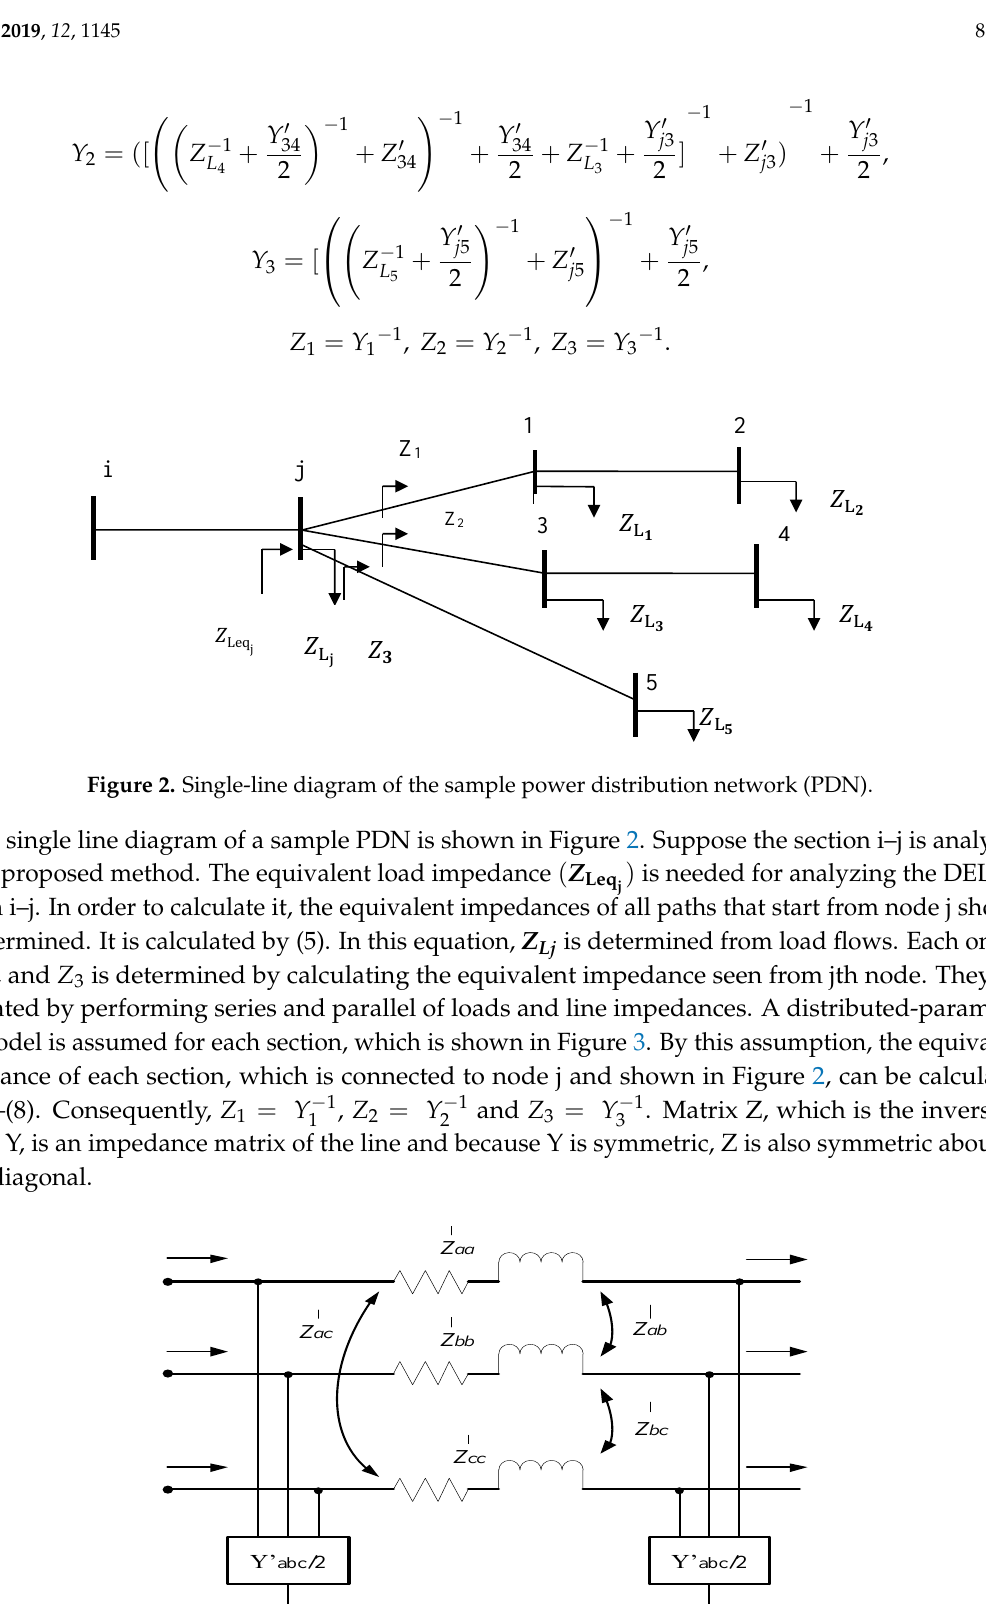
Figure 3. Circuit model of each section of the PDN.